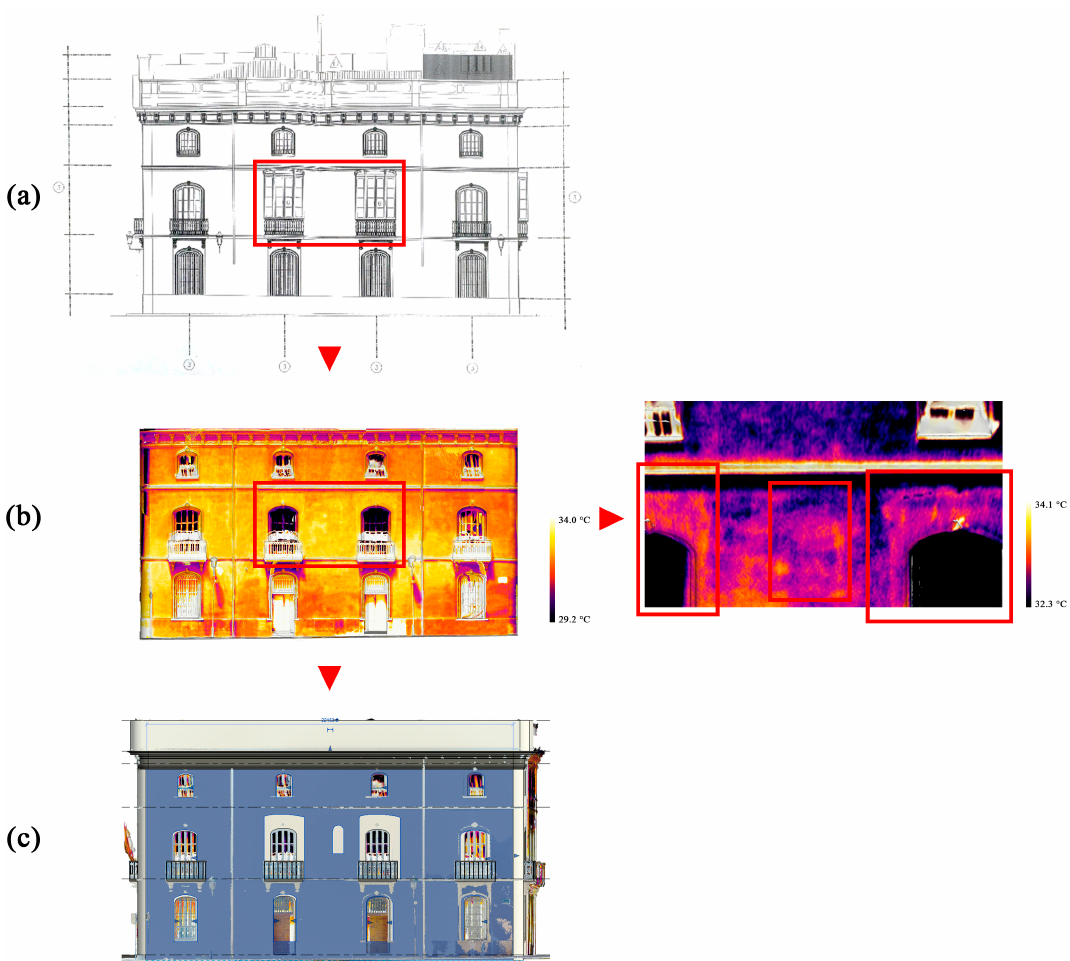
Figure 17. Eastern façade. Superimposition of different data in the HBIM environment: ( a ) condition mapping from 1995; ( b ) TIR orthoimagery showing the thermal anomalies (different temperature scales); ( c ) virtual reconstruction of the “A” and “C” anomalies according to the historical plan and further reconstruction of the central “B” anomaly. Remote Sens. 2022 , 14 , x FOR PEER REVIEW